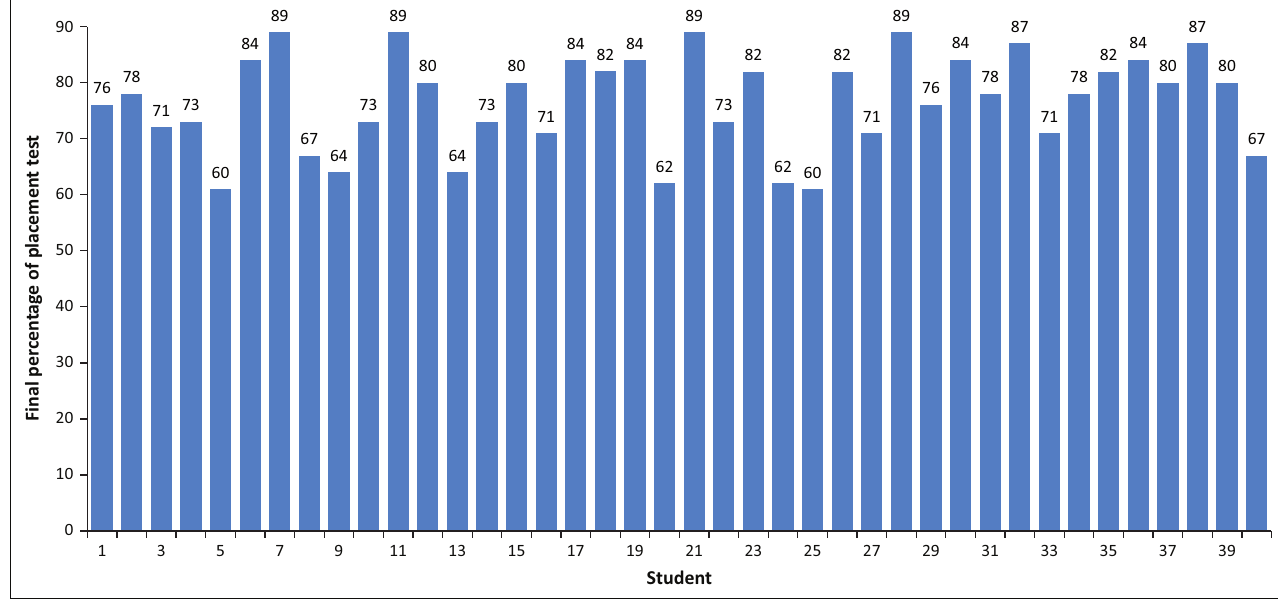
FIGURE 6: Placement test results for intermediary programme